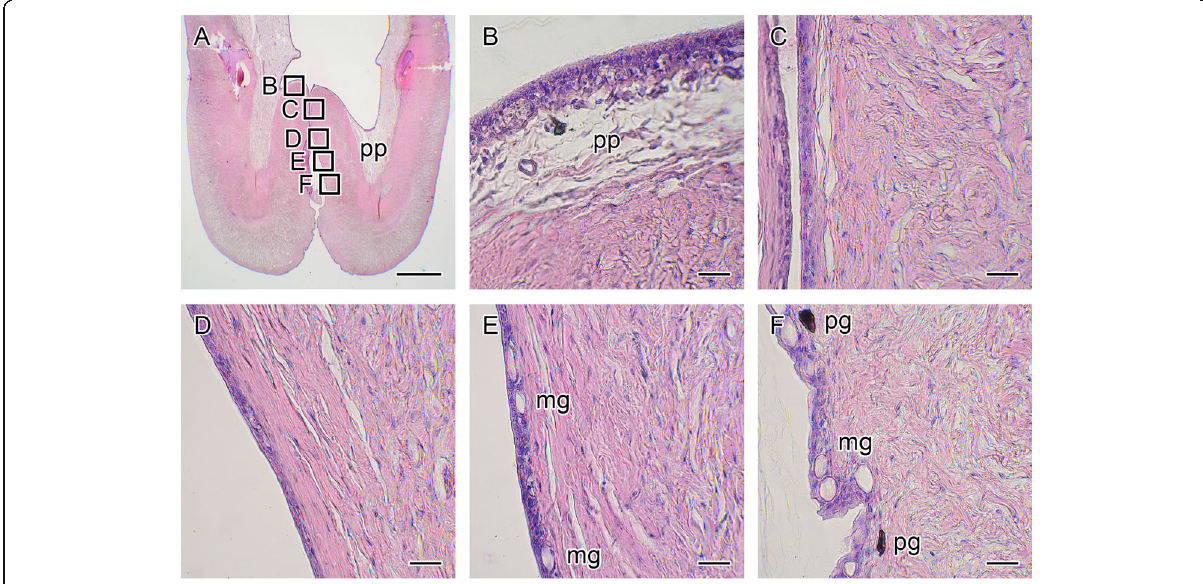
Fig. 2 Hematoxylin and eosin staining around the entrance of the seahorse brood pouch. A cross-section of the brood pouch around the entrance is shown in a . The dorsal side is at the top and the ventral side is at the bottom. The lettered boxes in a indicate sites of high-magnification views of the luminal epithelium ( b ) to the outer epithelium ( c – f ). mg, mucous granule; pg, pigment cell; pp, pseudoplacenta. Scale bars: a = 1 mm; b – f = 20 μ